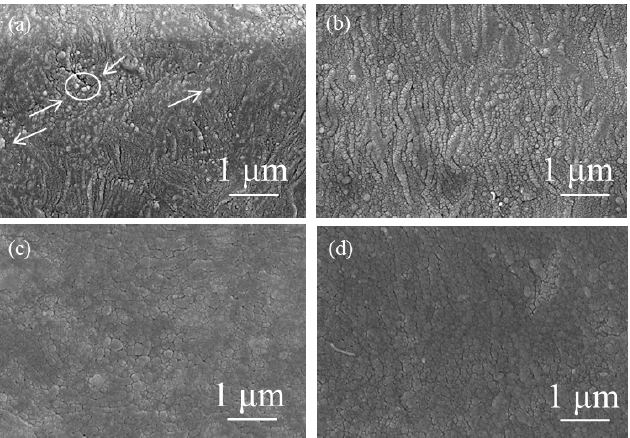
Figure 4. SEM morphologies of UHMWPE substrates treated with different carbon plasma currents: ( a ) 0.5 A, ( b ) 1.0 A, ( c ) 1.5 A, ( d ) 2.0 A.